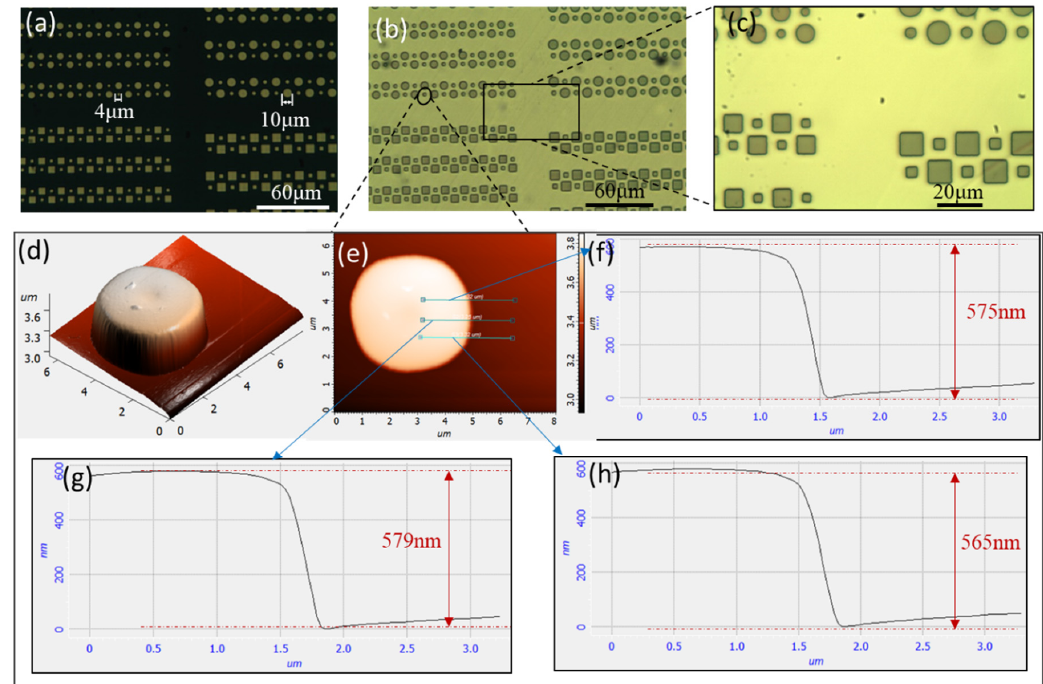
Figure 2. ( a ) Mask template observed under optical microscope; ( b , c ) photoresist patterns observed under optical microscope; ( d , e ) photoresist pattern observed under atomic-force microscopy; ( f – h ) the results of the step height characterization.